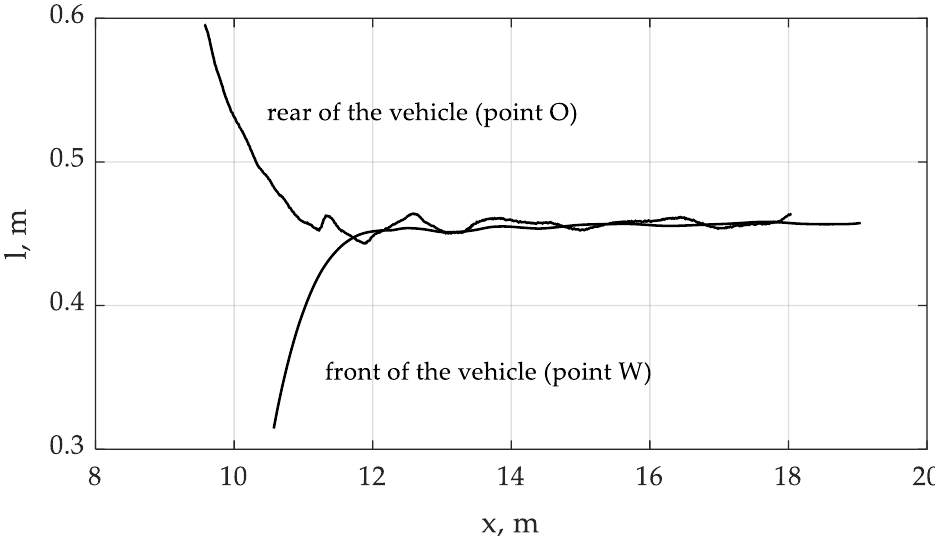
Figure 9. The course of the locations of the selected points W and O of the vehicle on a given route section.